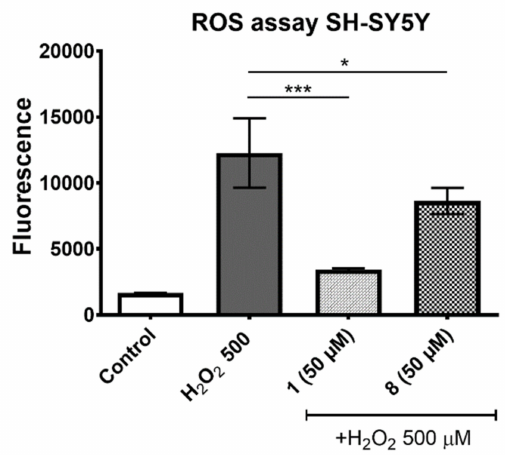
Figure 3. The protective effect of compounds 1 and 8 (50 µ M) against H 2 O 2 -induced increase of intracellular ROS level. Statistical significance was evaluated by one-way ANOVA, followed by Bonferroni’s comparison ( ∗ p < 0.05, ∗∗∗ p < 0.001 compared with the positive control—cells treated with 500 µ M H 2 O 2